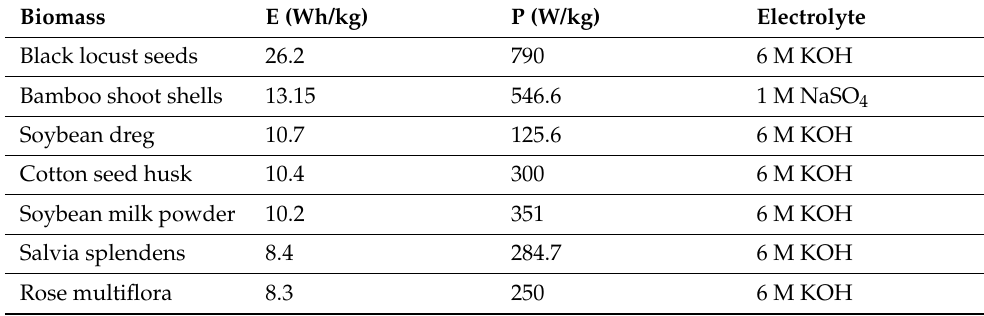
Table 2. Supercapacitor performance of plant-based heteroatom-doped biomass carbon electrodes. Biomass E (Wh/kg) P (W/kg)